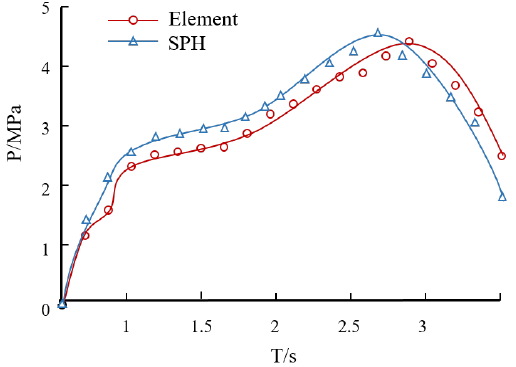
Figure 5. The pressure comparison curve between adjacent SPH particles and FEM grid.